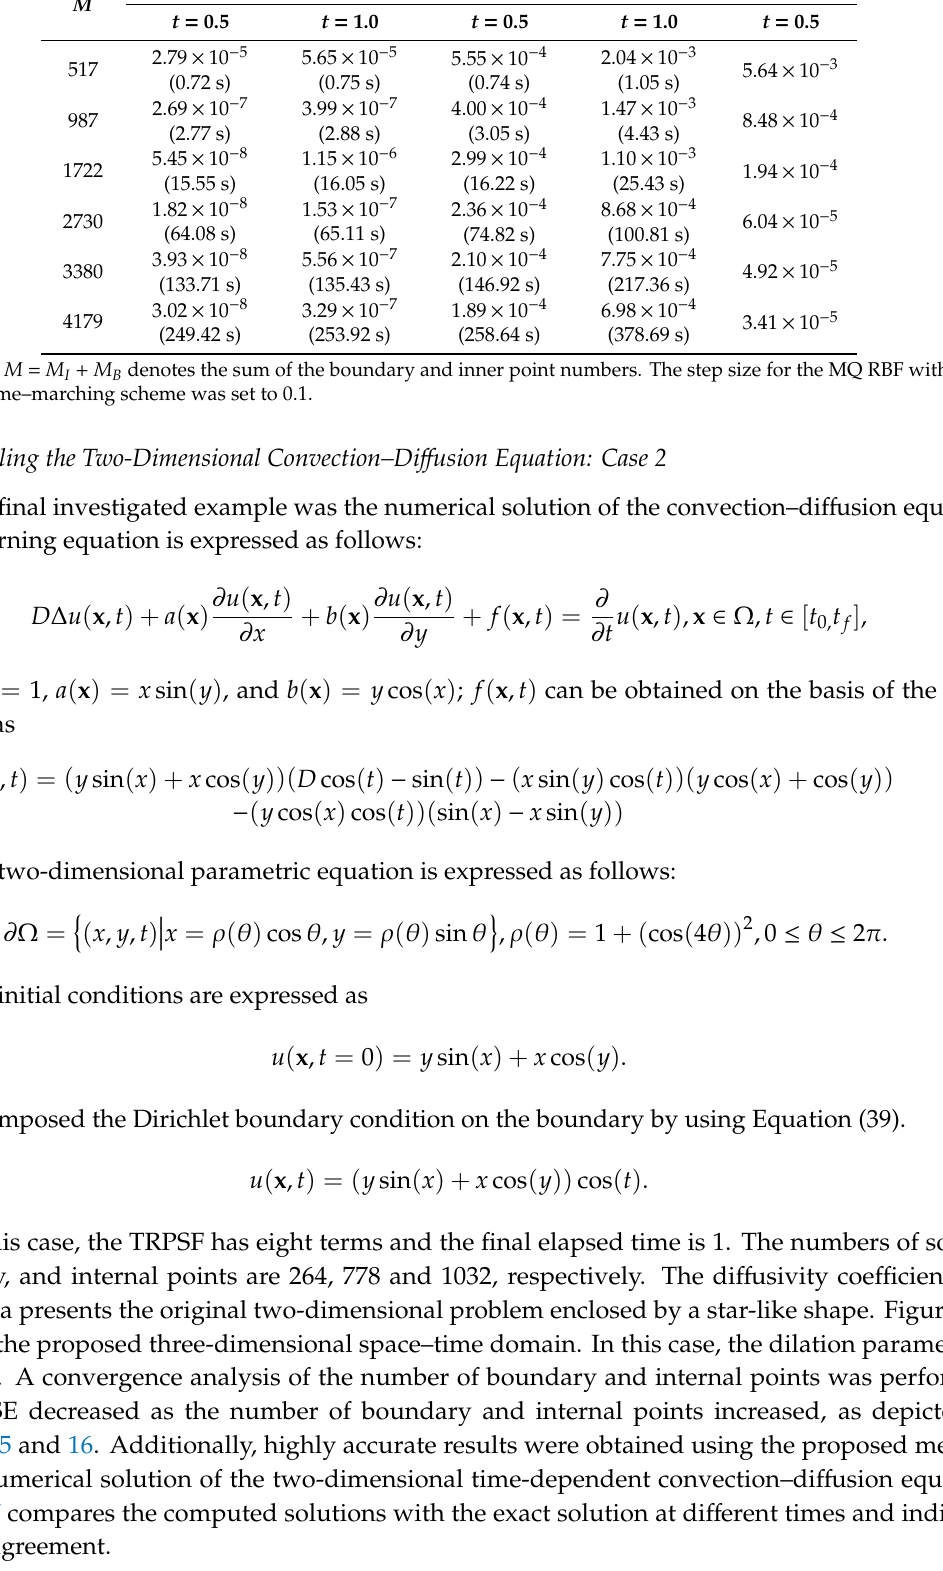
Table 4. RMSEs and CPU times of the presented method and the MQ radial basis function (RBF). This Study MQ M